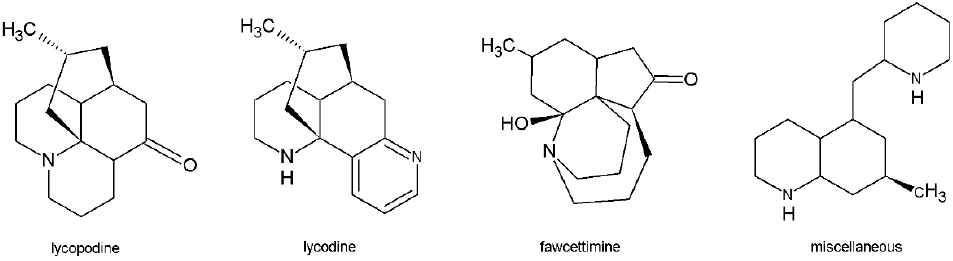
Figure 1. Representative compounds of the four main classes of Lycopodium alkaloids.